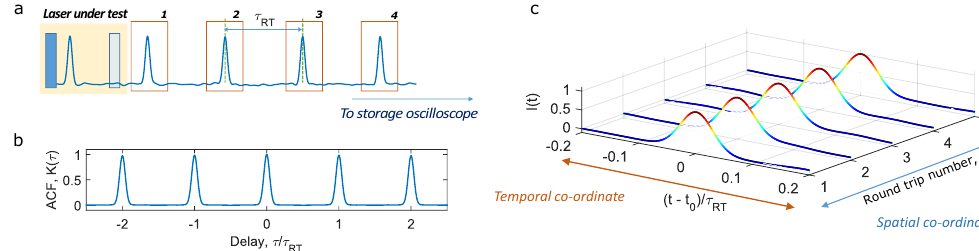
Figure 1. Principle of spatio-temporal dynamics—( a ) Intensity dynamics I ( t ) (simulated) depicting evolution over multiple round trips; ( b ) The autocorrelation K ( τ ) of the intensity dynamics I ( t ) . The periodic interval between the peaks gives the round trip time τ RT ; ( c ) The spatio-temporal dynamics, describing evolution of the pulse features. Horizontal co-ordinate—temporal, vertical